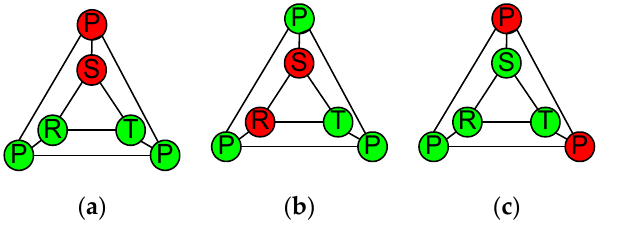
Figure 4. ( a ) A dictatorship as a PMC model; ( b ) the COVID-19 pandemic as a PMC Model; ( c ) a trust failure as a PMC model.